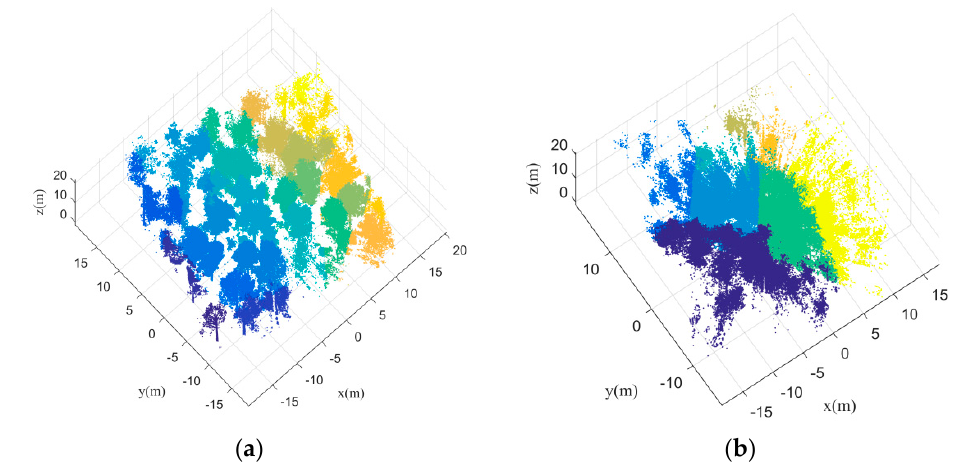
Figure 19. Initial segmentation results for easy and difficult plots. ( a ) Plot 1 scanned in single mode; ( b ) plot 6 scanned in single mode.